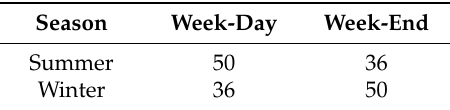
Table 2. Number of measurements performed over weekdays and weekends in each